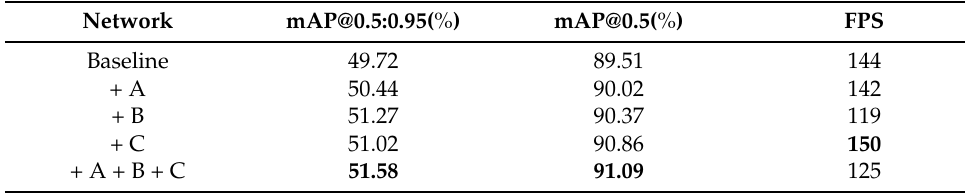
Table 6. Results of ablation experiments in the PCB